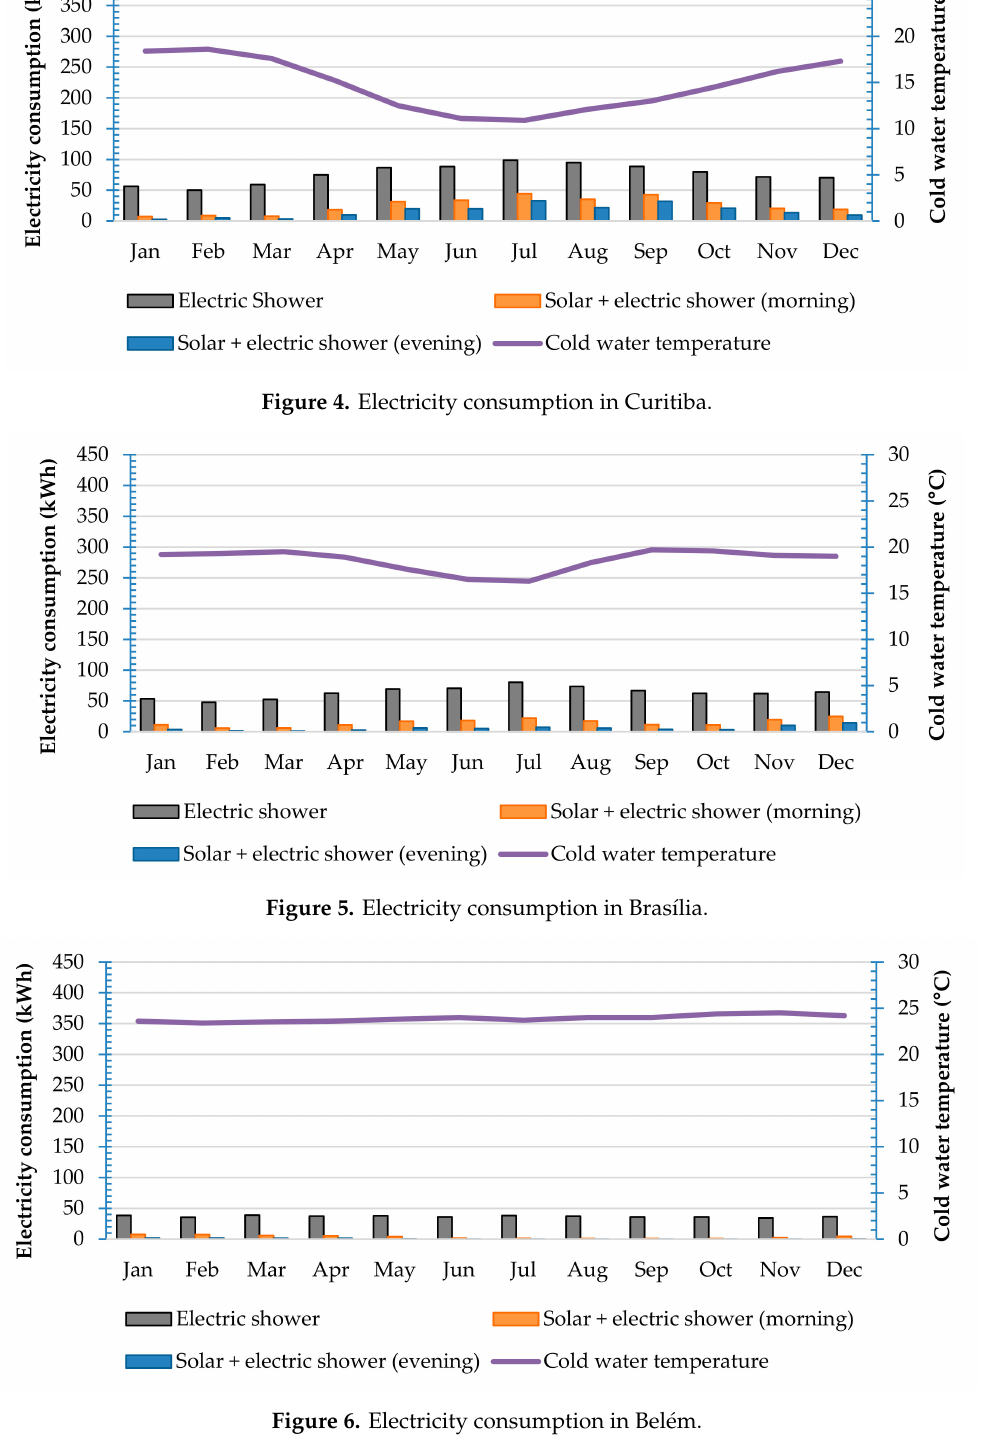
Figure 6. Electricity consumption in Bel é